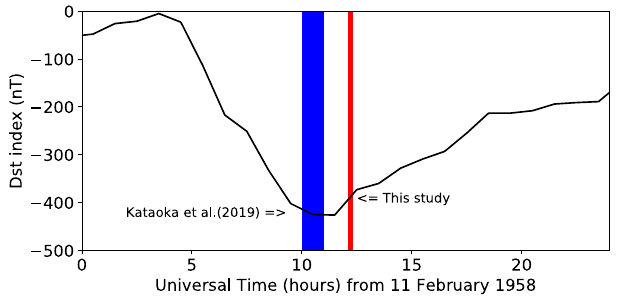
Fig. 2. The Dst index of the magnetic storm on 11 February 1958, as obtained from Kyoto University. This study is about the early recovery phase (red), while the time interval of Kataoka et al. (2019) is just before the peak time of the magnetic storm (blue).